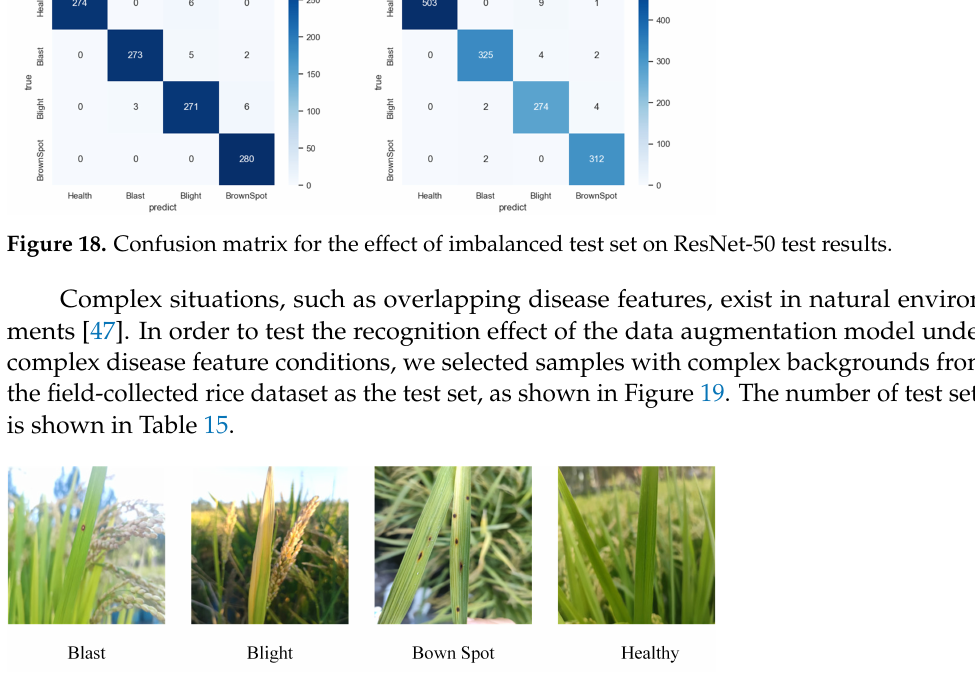
Figure 19. Datasets in complex environments. Table 15. Details of the datasets in complex environments.